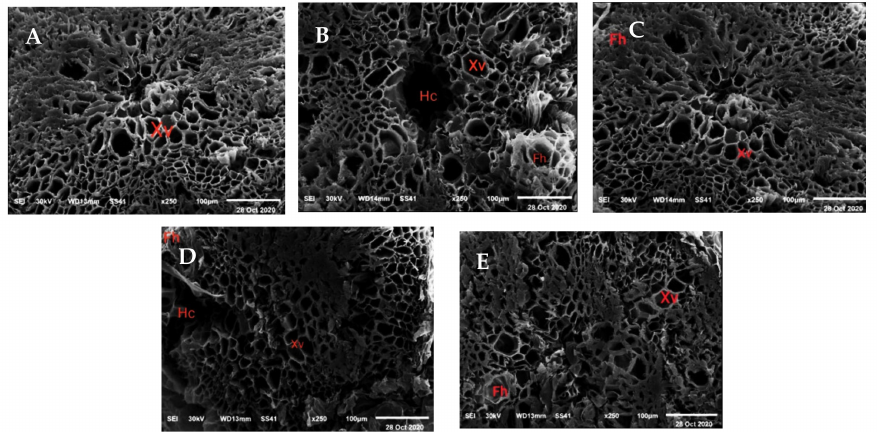
Figure 5. SEM micrograph of kidney bean root cross sections under infested soil with Pythium ultimum , ( A ): check (treated with fungicide), ( B ): fungal infection without treatment, ( C ): treated with extract + T. h., ( D ): treated with Trichoderma harzianum and ( E ): treated with extract. Xv = Xylem vessels, Hc = hydrolyzed cells, Fh = Fungal